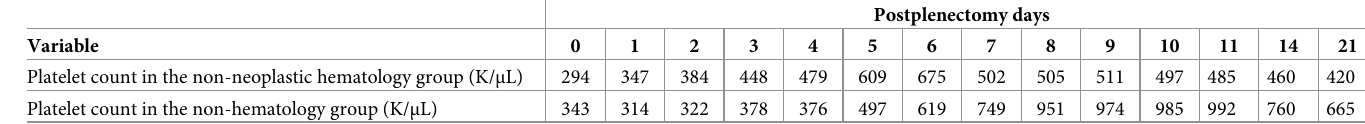
Table 3. The comparison of platelet counts between the non-neoplastic hematology vs . non-hematology group. Variable Platelet count in the non-neoplastic hematology group (K/ μ L) Platelet count in the non-hematology group (K/ μ L) K/ μ L, kilo per